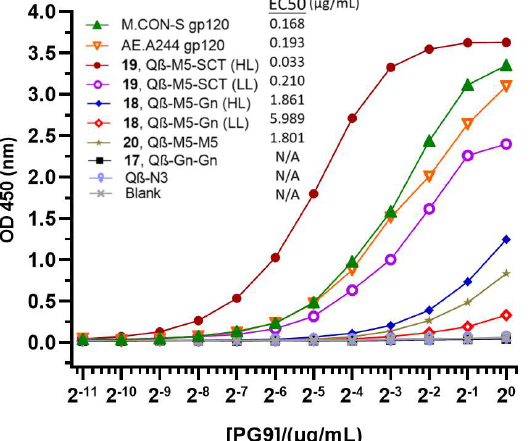
Figure 3. Conventional ELISA binding of V1V2 antigens to bNAb PG9. Q β -V1V2 conjugates or gp120 were coated on the microtiter plates. PG9 was titrated with two-fold serial dilutions starting from 1 μg/mL. LL = low-loading (below 1 peptide/subunit); HL = high-loading (1–2 peptides/subunit); Blank is PBS buffer. Two independent ELISA assays were performed and the results were con- sistent. The figure shows a representative set of the data.